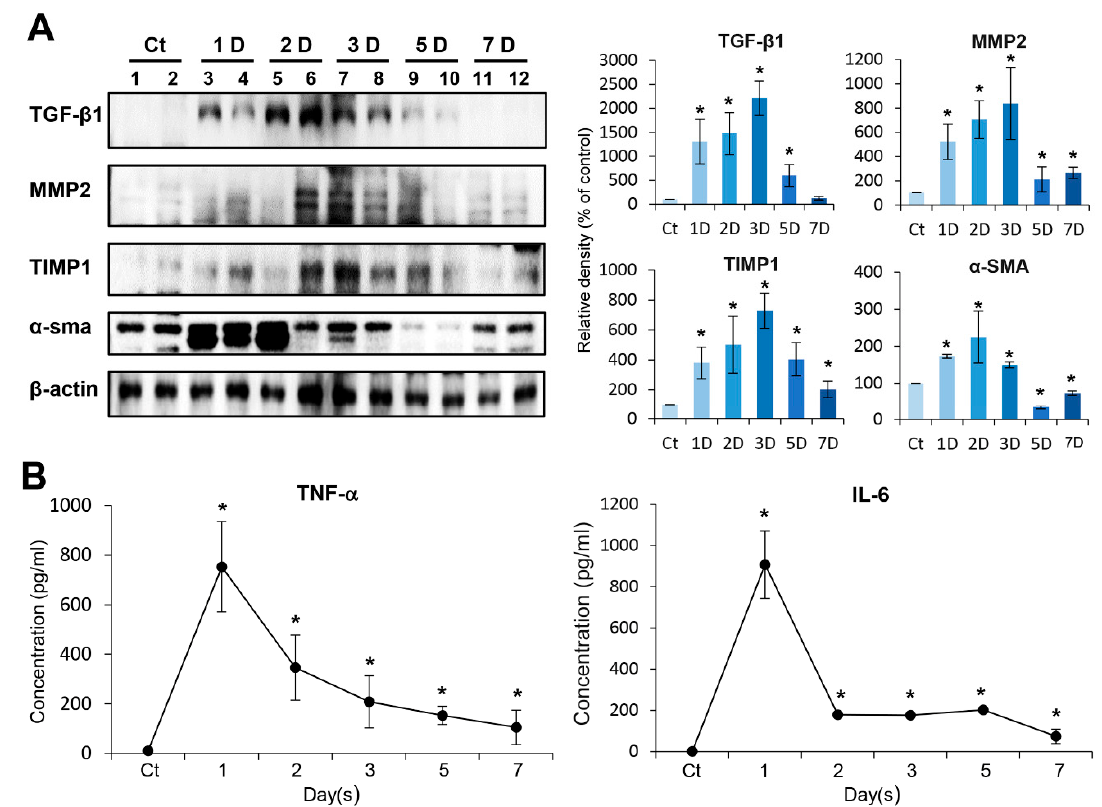
Figure 2. In vivo determination of profibrotic property of penicillin G. ( A ) Western blot analysis of mouse pancreas after direct injection of penicillin G into mouse pancreas over time. The expression of TGF- β 1, MMP2, and TIMP1 in the pancreas gradually increased and peaked after three days of injection with penicillin, and then decreased gradually. The expression of α -SMA peaked at the second day after injection and gradually decreased thereafter. ( B ) Enzyme linked immunosorbent assay (ELISA) of serum pro-inflammatory cytokines (IL-6 and TNF- α ) after injection of penicillin G over time. The levels of IL-6 and TNF- α peaked at day 1 post-injection with penicillin, and almost subsided by seven days post-injection. Values are presented as mean ± standard deviation of three independent experiments.